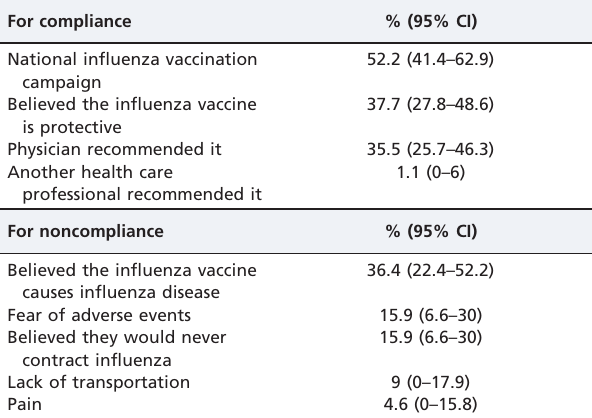
Table 2 - Referenced reasons for influenza vaccination compliance or noncompliance in